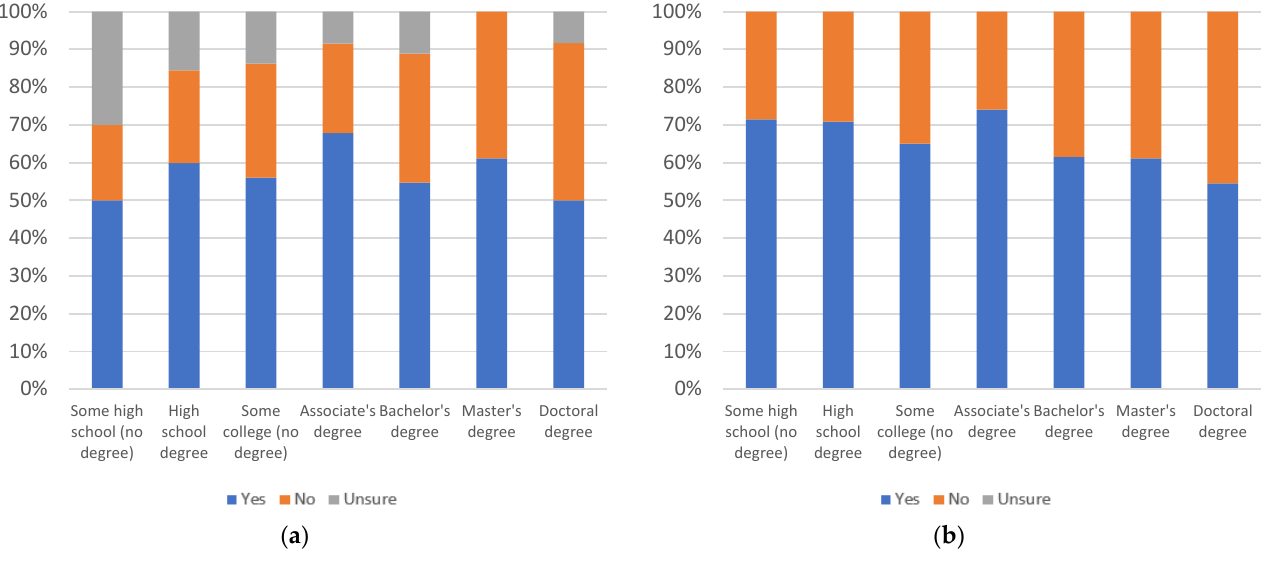
Figure 102. Label helpfulness, by education level: ( a ) with uncertain respondents (left) and ( b ) with- out uncertain respondents (right).